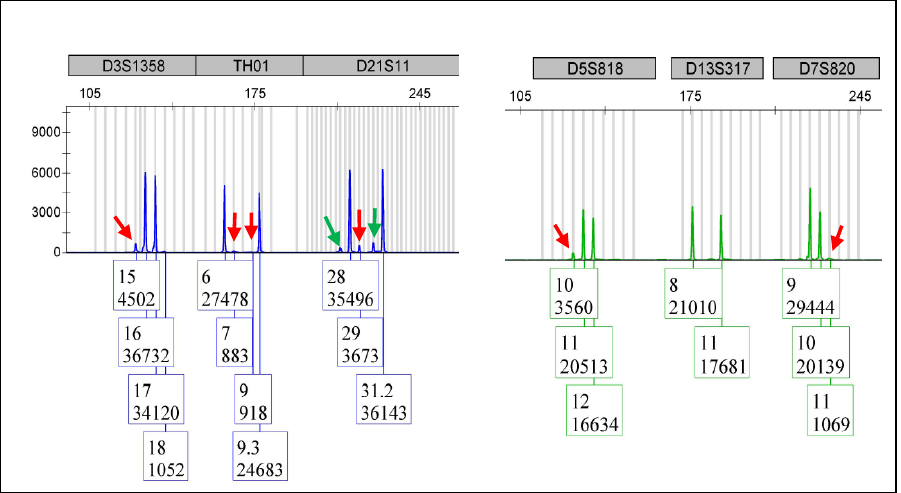
Figure 4. This figure consists of the electropherograms from multiple samples of the same category to protect the DNA fingerprint of any one sample. The DNA from two individuals were mixed with one of them contributing 5% of total DNA as a surrogate of contaminating DNA. Such ‘contaminating’ DNA was detected as indicated by the low peaks (red arrows). Please note that D13S317 is a non- informative marker for this mixture. The two low peaks of D21S11 (green arrows) can be considered as